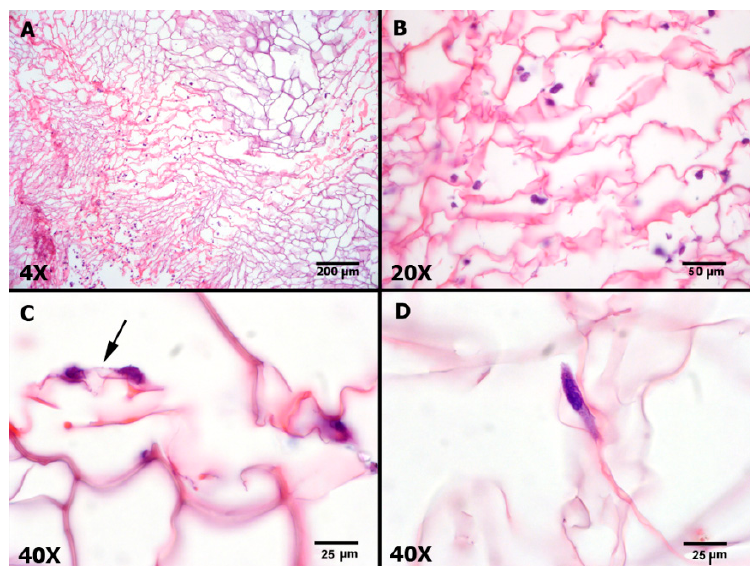
Figure 4. Hematoxylin and Eosin (H&E) stained histological sections of the chitosan/collagen scaffold seeded with AT-MSCs after seven days in culture. ( A , B ) Panoramic view of AT-MSCs uniform distribution into the scaffold; ( C ) Arrow indicates the interaction of two cells on the scaffold; ( D ) Detail of AT-MSC adhered on the scaffold.